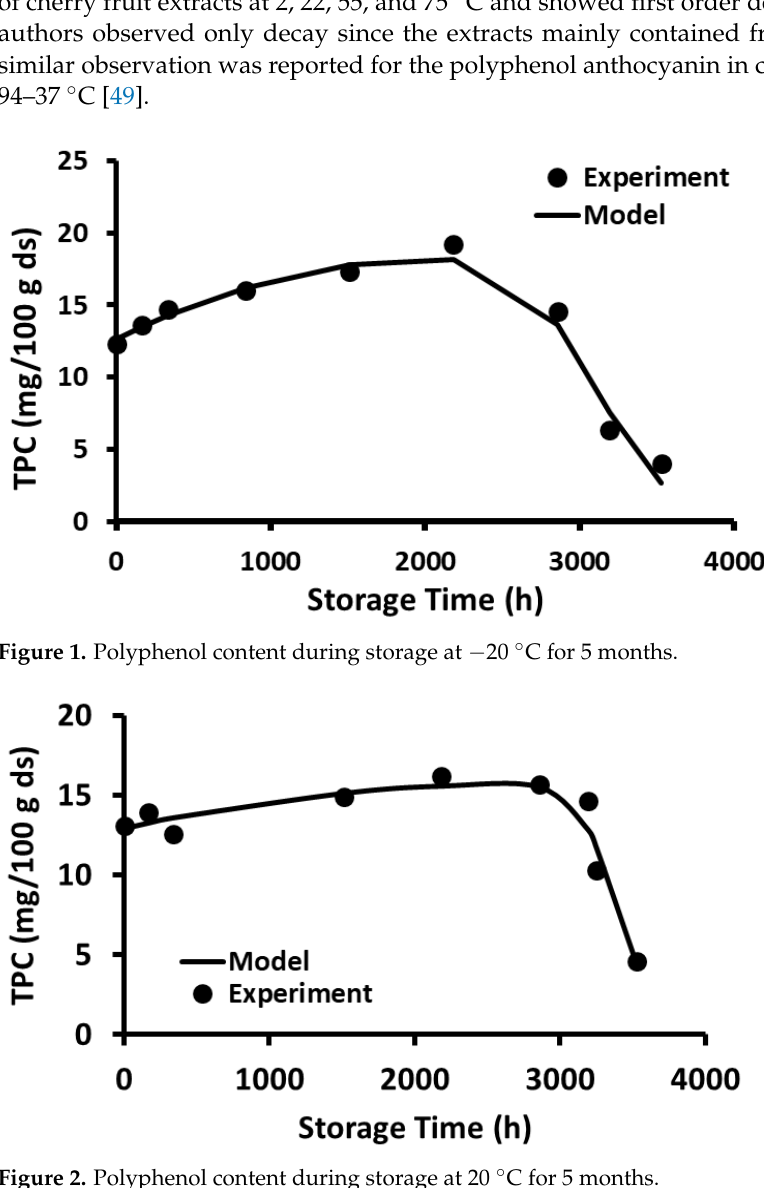
Figure 3. Polyphenol content during storage at 40 °C for 63 days. Figure 4. Polyphenol content during storage at 60 °C for 14 days.